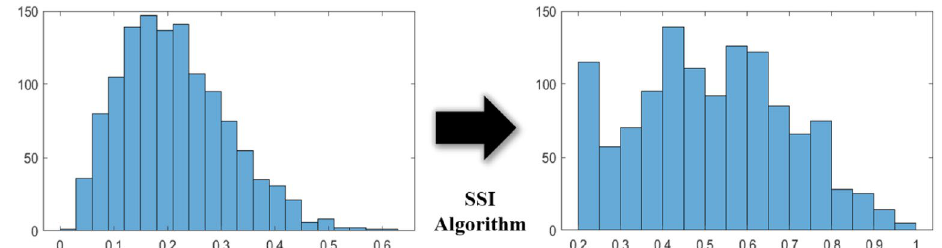
Figure 4. Effect by sequential spatial inhibition (SSI) algorithm.